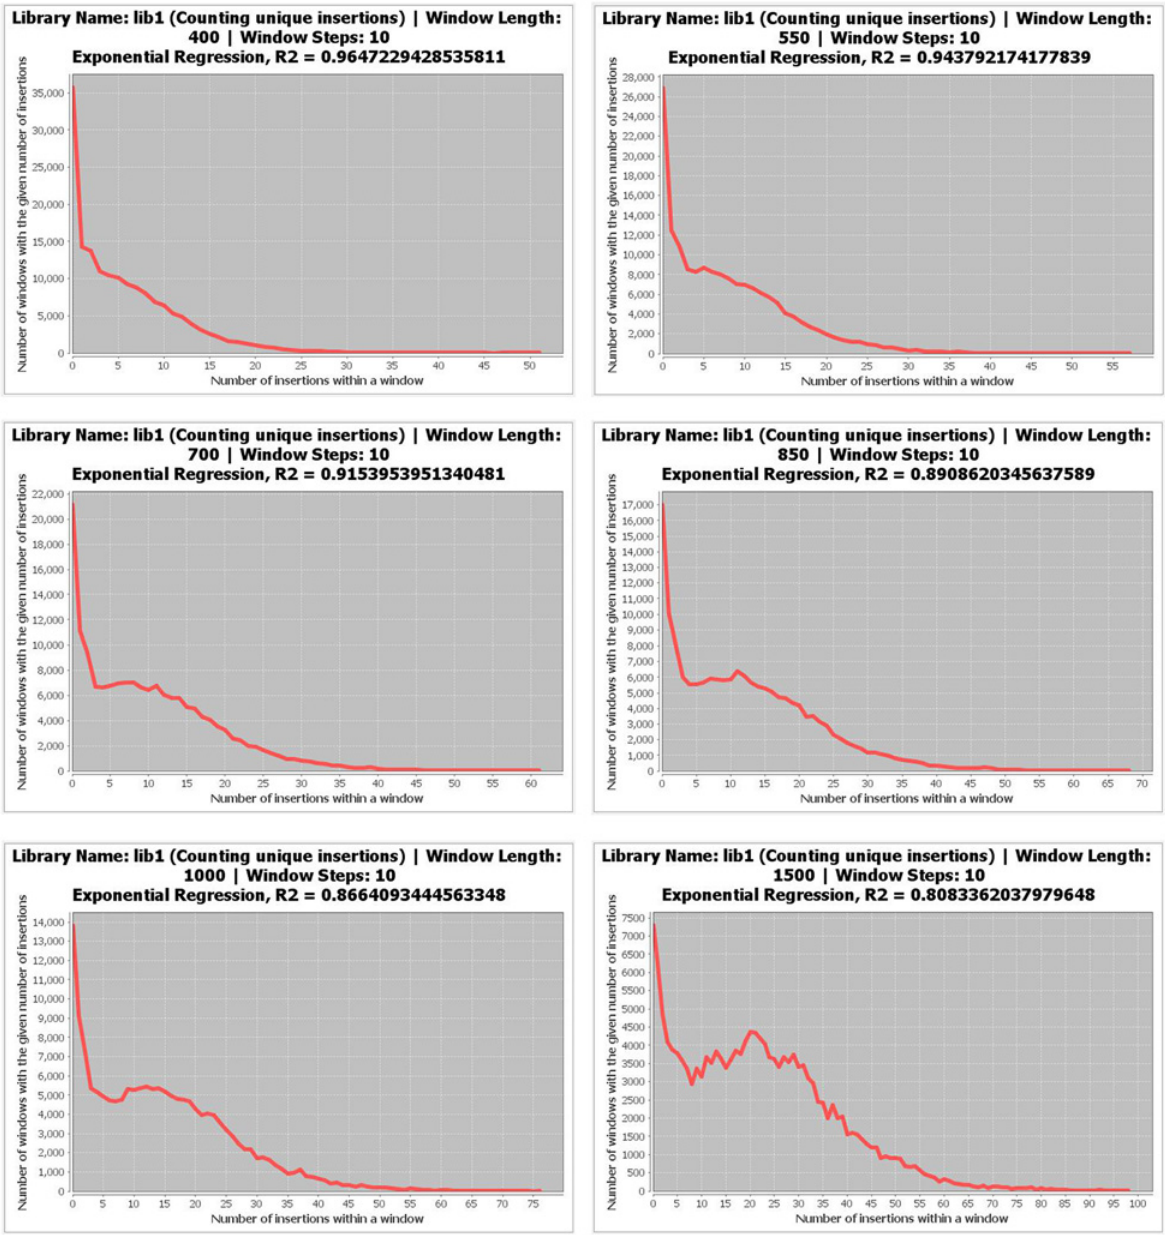
Fig 1. Screenshots of distribution of unique insertions per window for window sizes 400, 550, 700, 850, 1000, and 1500 bp. The analyzed genome ( M . maripaludis S2) was scanned with a sliding window of the given size shifted by 10 bp in each step, counting the number of unique transposon insertions within each window. The vertical axis shows the number of window positions that yield the insertion count shown by the horizontal